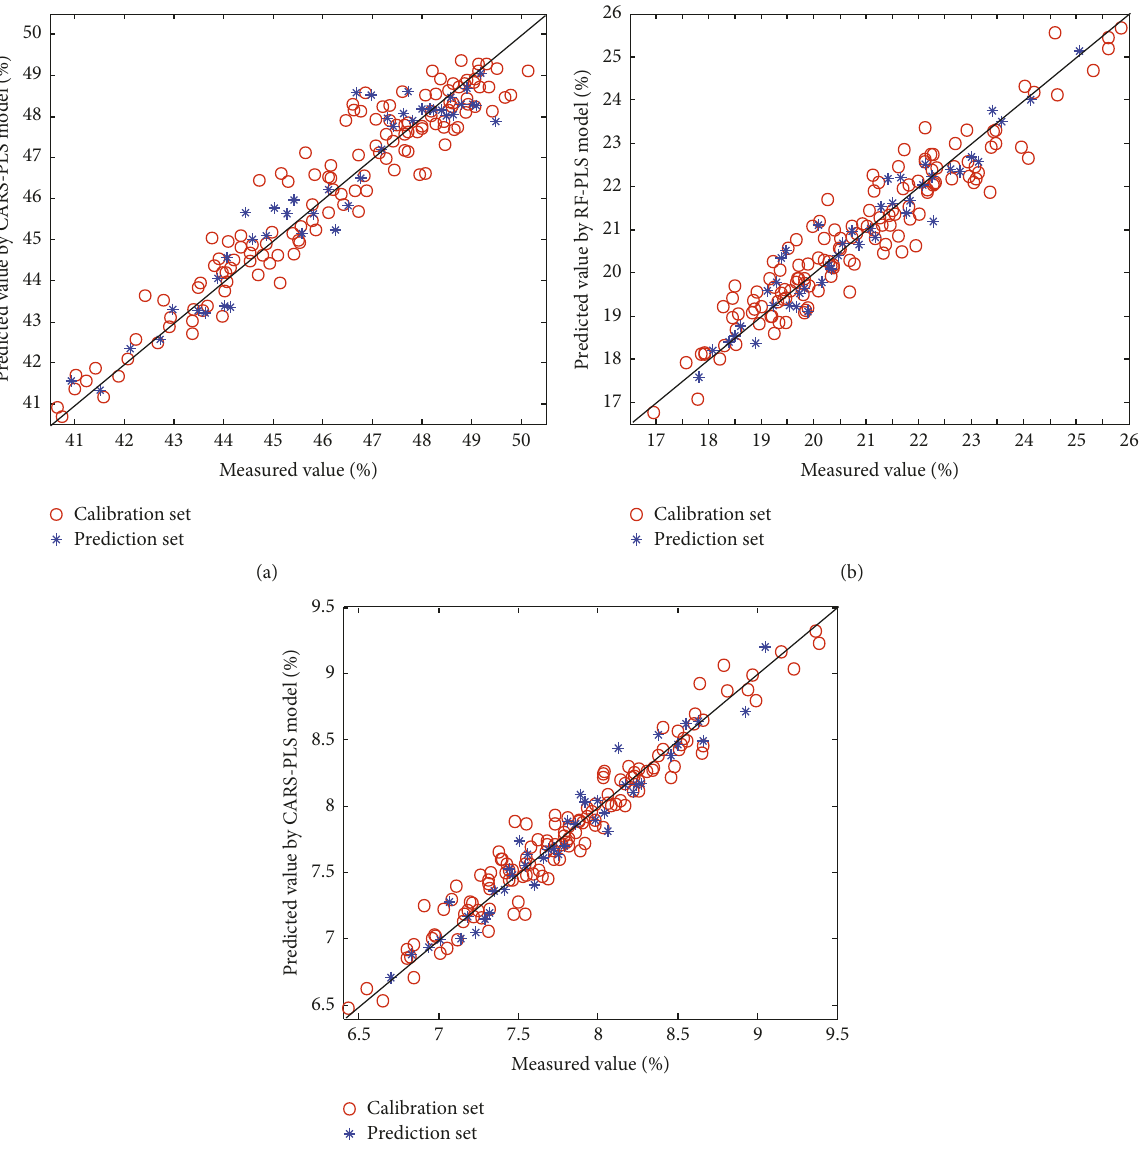
Figure 7: Scatter plots of predicted versus measured (a) protein, (b) lipid, and (c) moisture contents of Fuzhu.